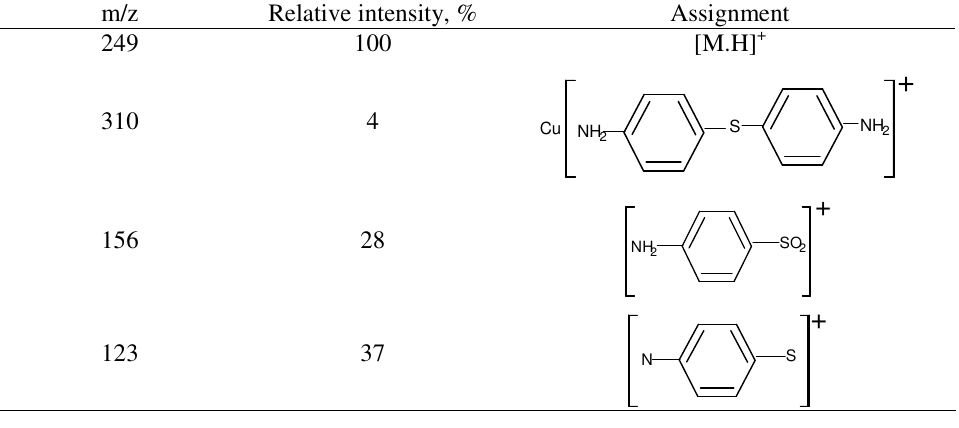
Table 3. Mass Spectra Assignments for [Cu (DAP)(NO